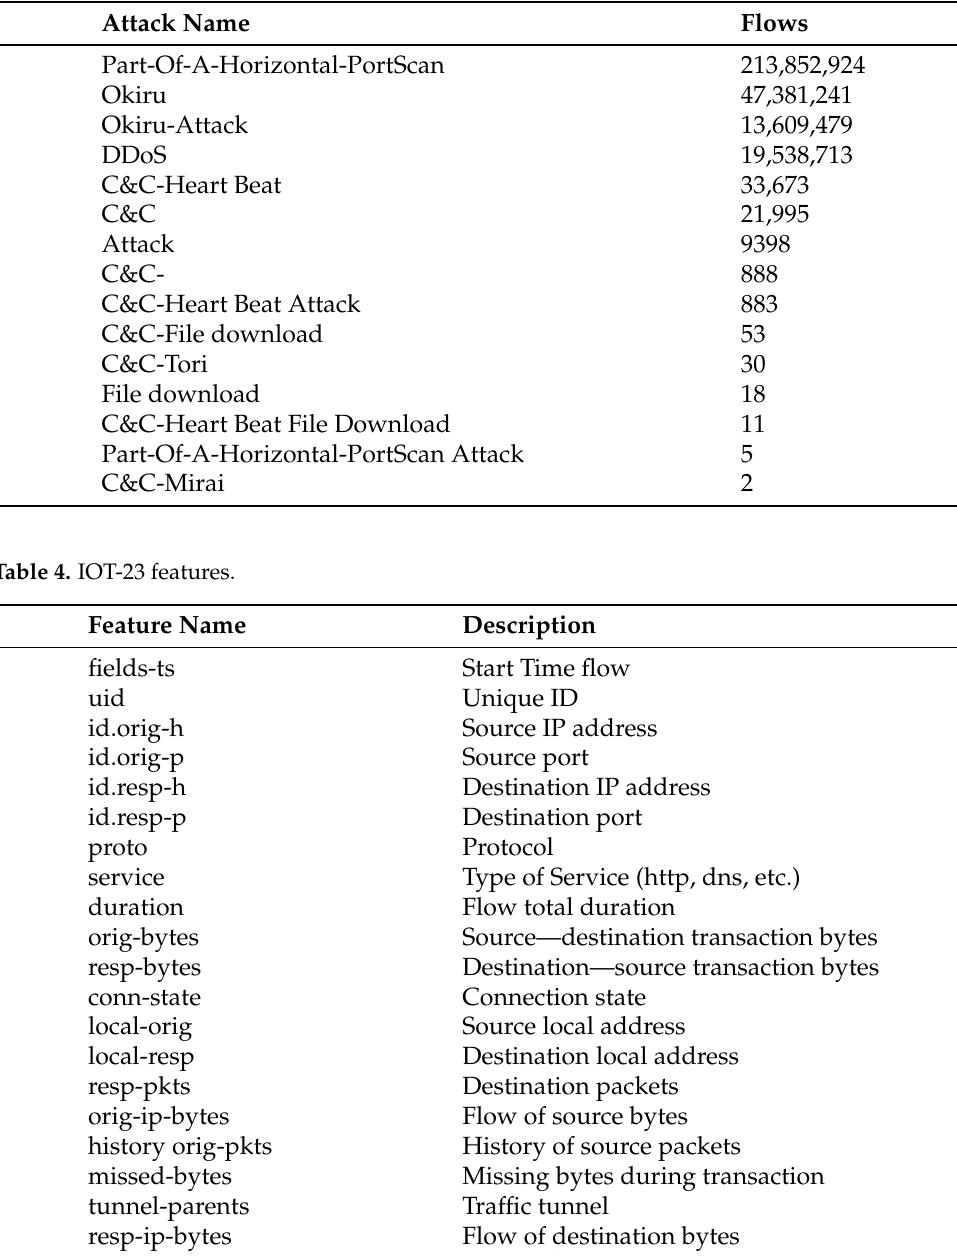
Table 3. Representation of the traffic content of the IoT-23 dataset by executed attacks.